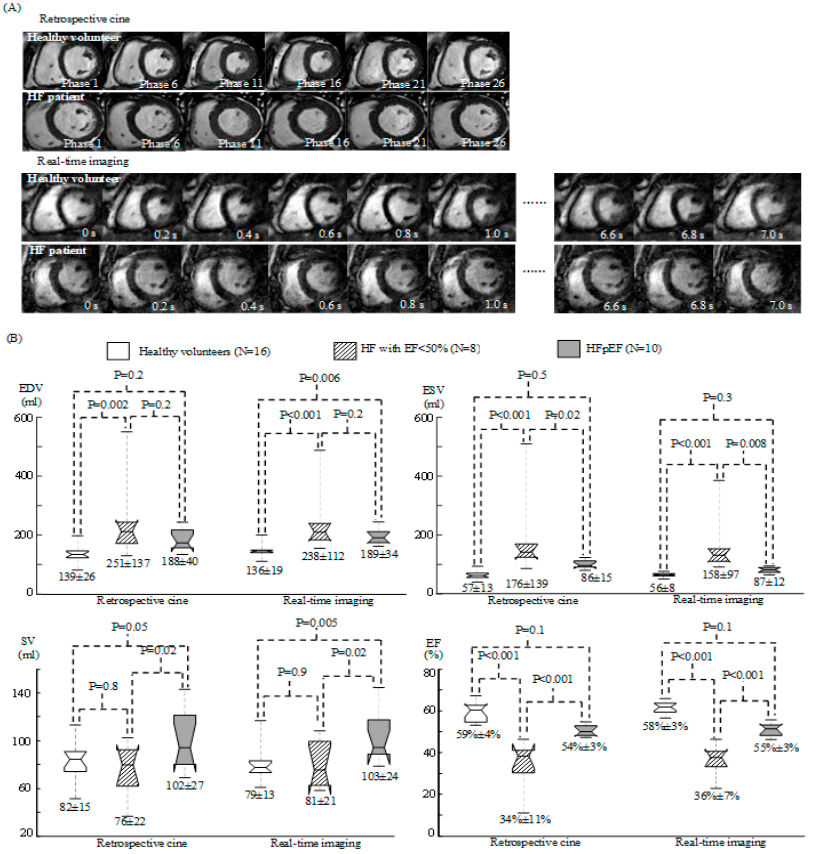
Figure 2. ( A ) Selected time frames of the retrospective cine and real-time images in a healthy volunteer and a heart failure patient. ( B ) Box plots for EDV, ESV, SV and EF measurements with retrospective cine and real-time imaging in the healthy volunteers and HF patients. The numbers above the boxes provide the P values from one-way ANOVA statistics and those below the boxes are the mean and standard deviation in each subject group.